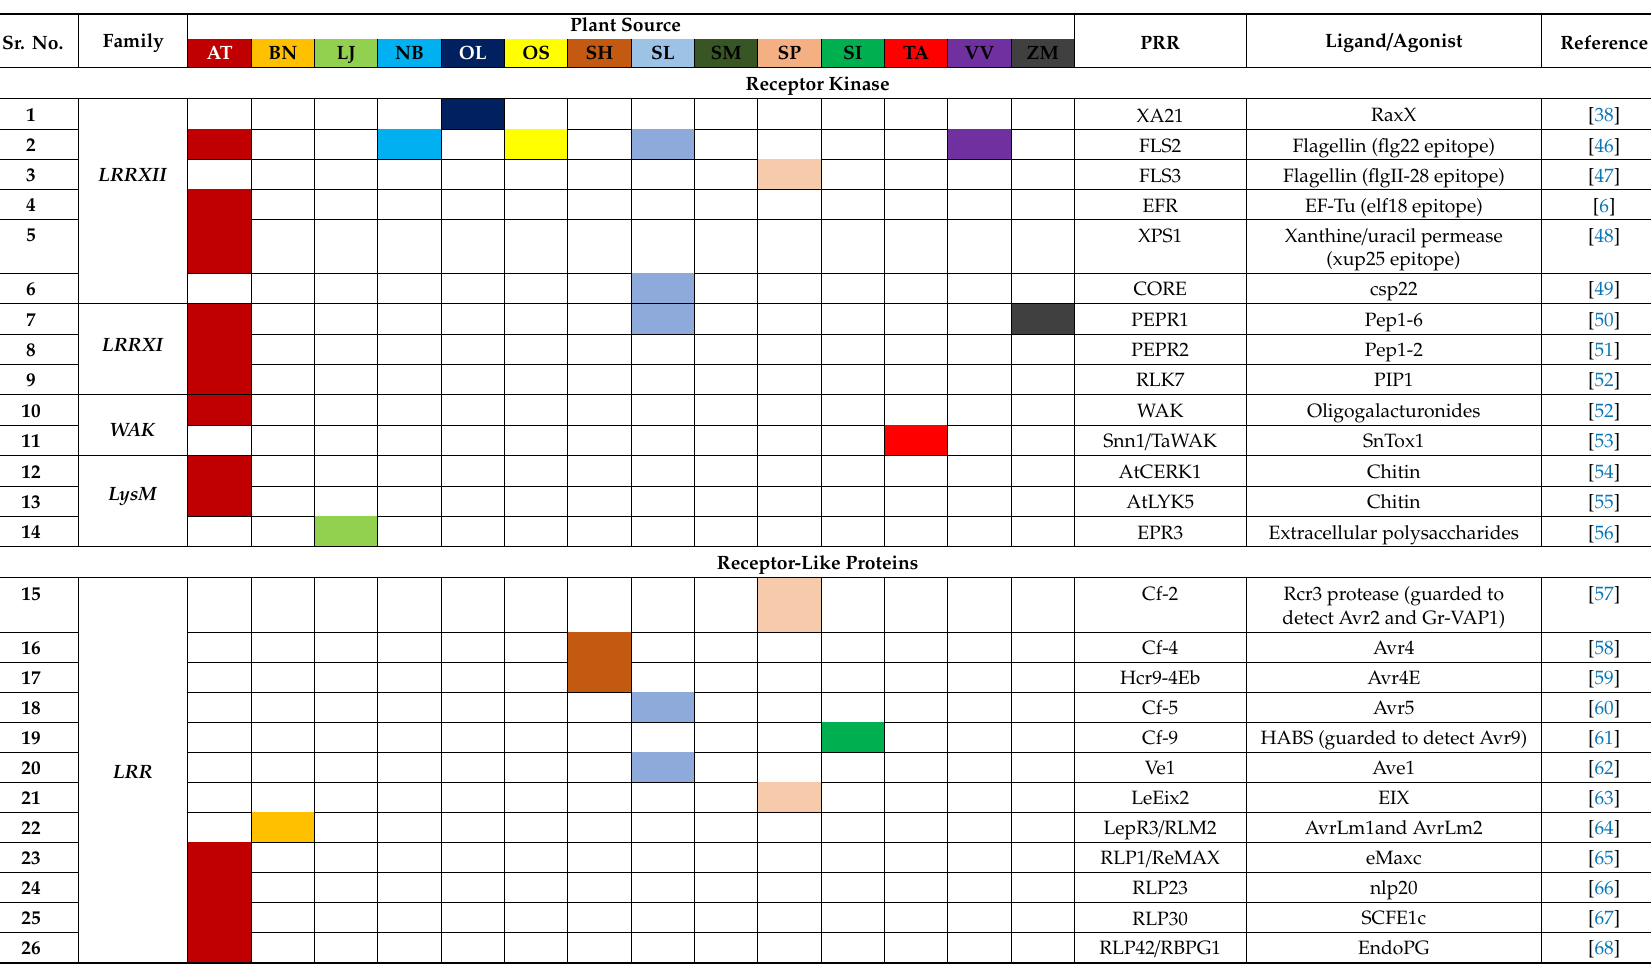
Table 1. Many pattern-recognition receptors (PRRs) have been discovered in di ff erent plant species. PRRs can be categorized as receptor kinases or receptor-like proteins. Ligand recognition by PRRs leads to Pathogen Associated Molecular Pattern (PAMP)-Triggered Immunity (PTI). This table highlights PRR types along with their ligands /